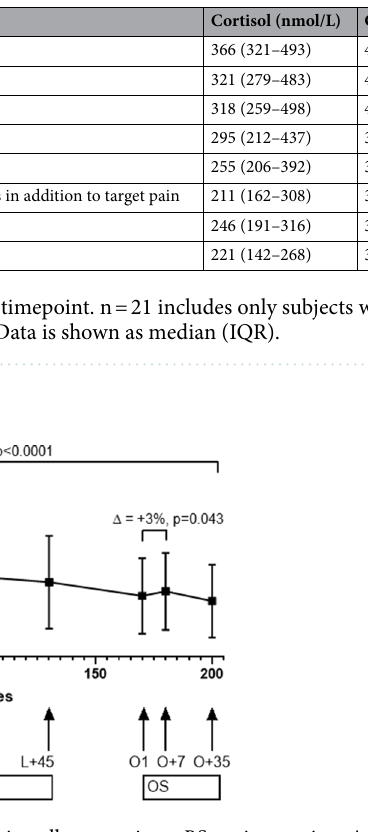
Figure 2. Time plot of cortisol during all test sessions. RS resting session. ∆ = −13%, p < 0.0001. LS learning session. ∆ = −24%, p = 0.0002. L1 time point when reaching target pain. L + 15 time point L1 plus 15 min. L +